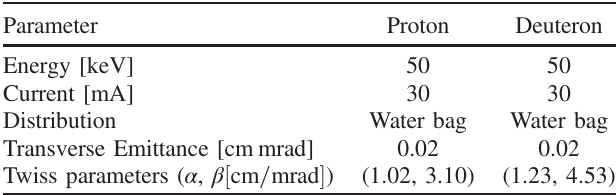
TABLE II. Ion Source used in this study. Parameter